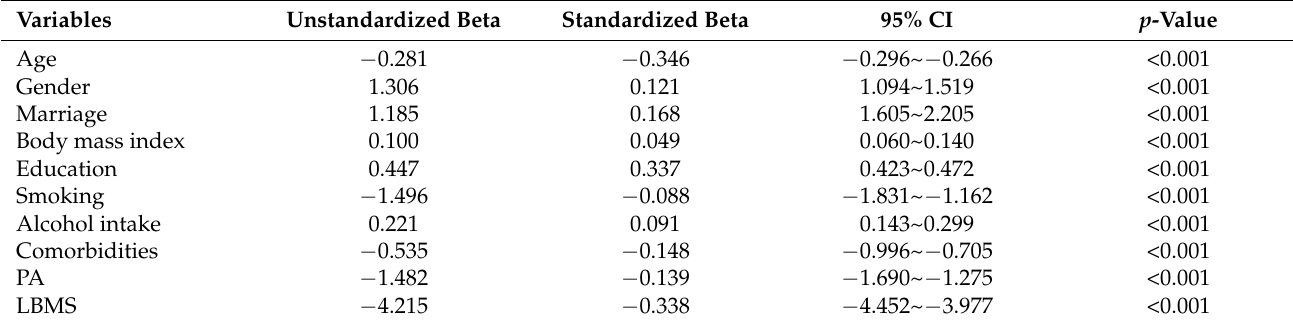
Table 2. Beta coefficients of simple linear regression for cognitive function.